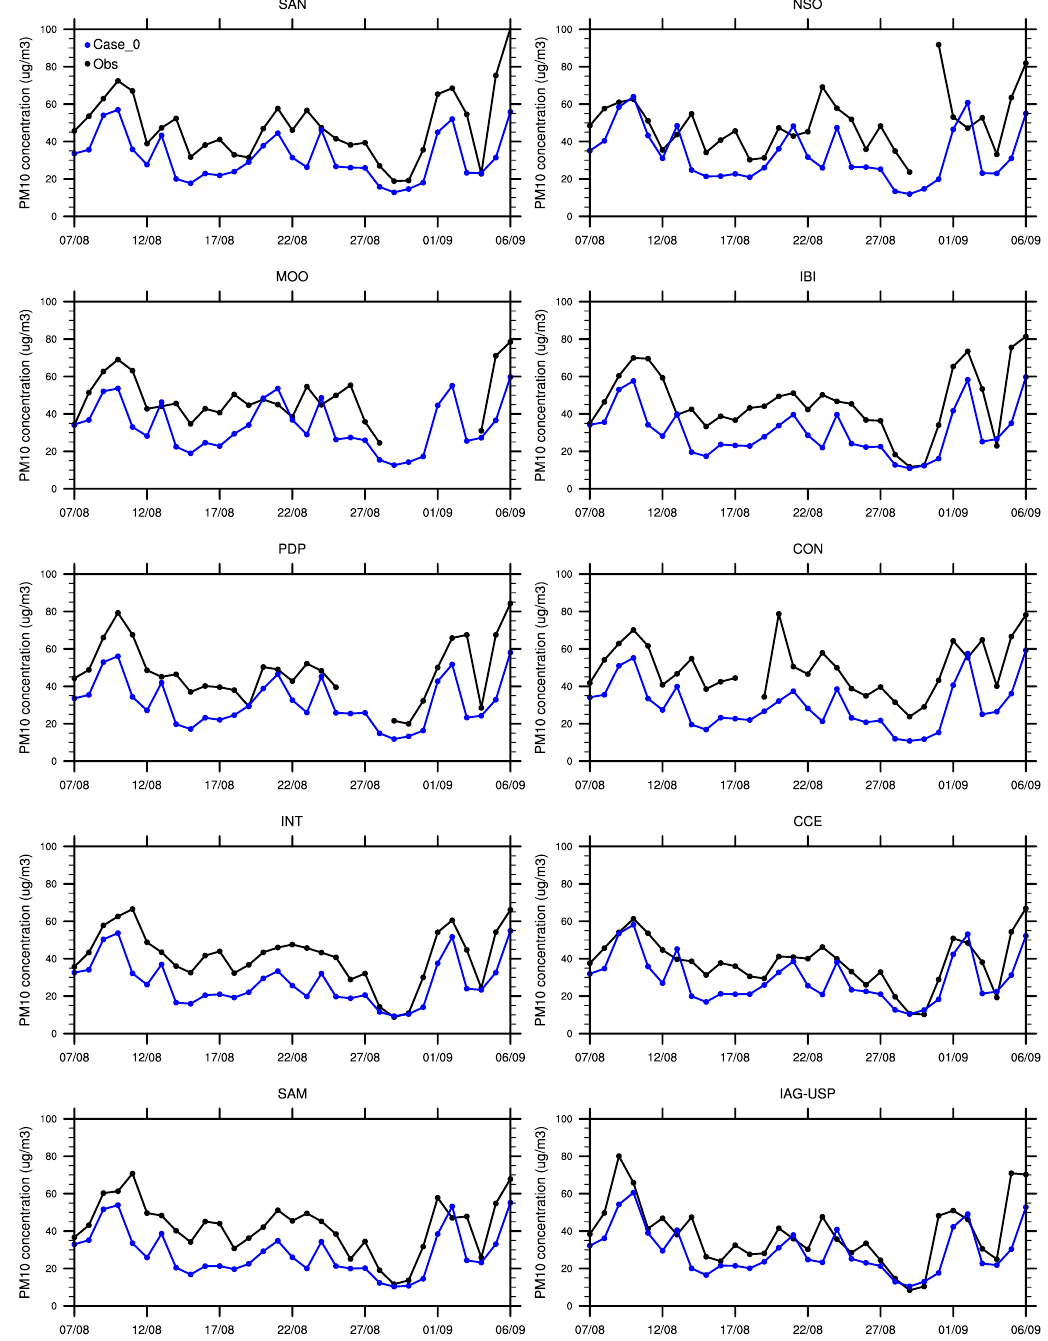
Figure 8. The observed and predicted daily variations of PM 10 concentrations at 10 sites in SPMA for the 3km modelling domain.